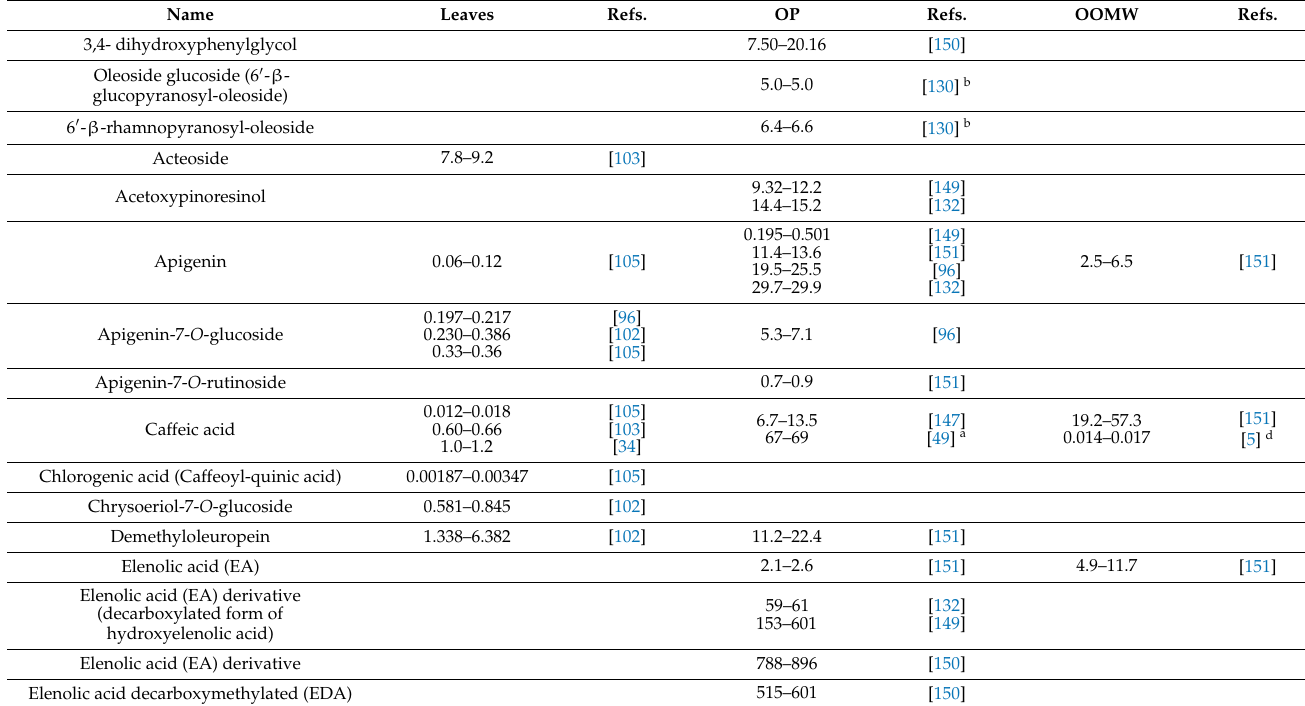
Table 3. Range of concentrations of bioactive compounds reported in leaves (mg/g), olive pomace (mg/kg) and in olive oil mill wastewaters (mg/kg)